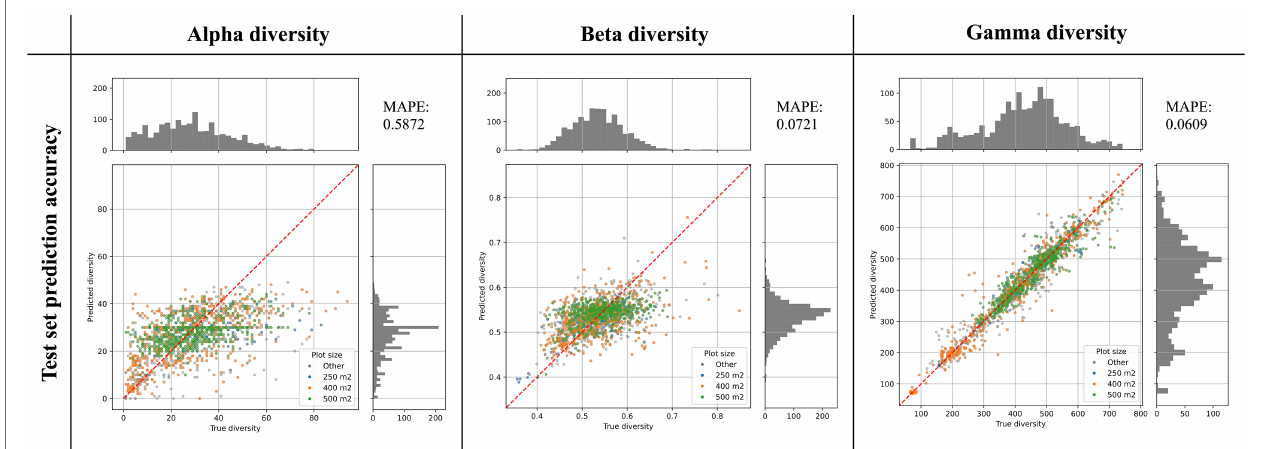
FIGURE 3 | Prediction accuracy of best models as determined on an independent test set. The scatter plots show the predicted diversity (y-axes) plotted against the true diversity (x-axes) for the best alpha, beta, and gamma diversity models. These estimates were made for a randomly selected and independent test set ( N = 1,579 instances), exclusively consisting of instances that were not used during model training. The points are colored by the vegetation plot-size associated with each data point (see legend). The red diagonal line shows for reference the best-case scenario, if all labels were predicted 100% accurately. Histograms show the total distribution of values for the true diversity values (top) and the predicted diversity values (right). For each model we calculated the Mean Absolute Percentage Error (MAPE), shown in the top-right corner of each